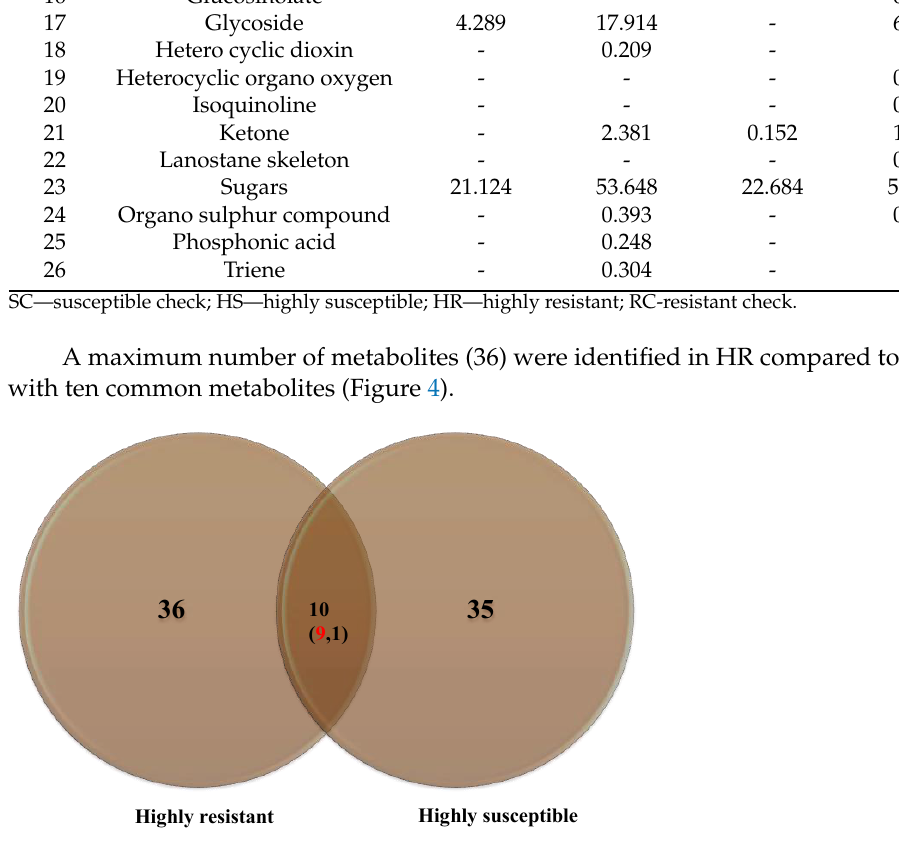
Figure 4. Number of metabolites accumulated in the highly resistant and highly susceptible geno- types. Numbers in the parenthesis indicate upregulated (red) and down-regulated metabolites (black).